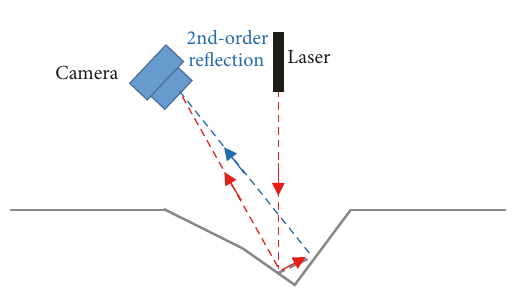
Figure 26: Spurious reflection.